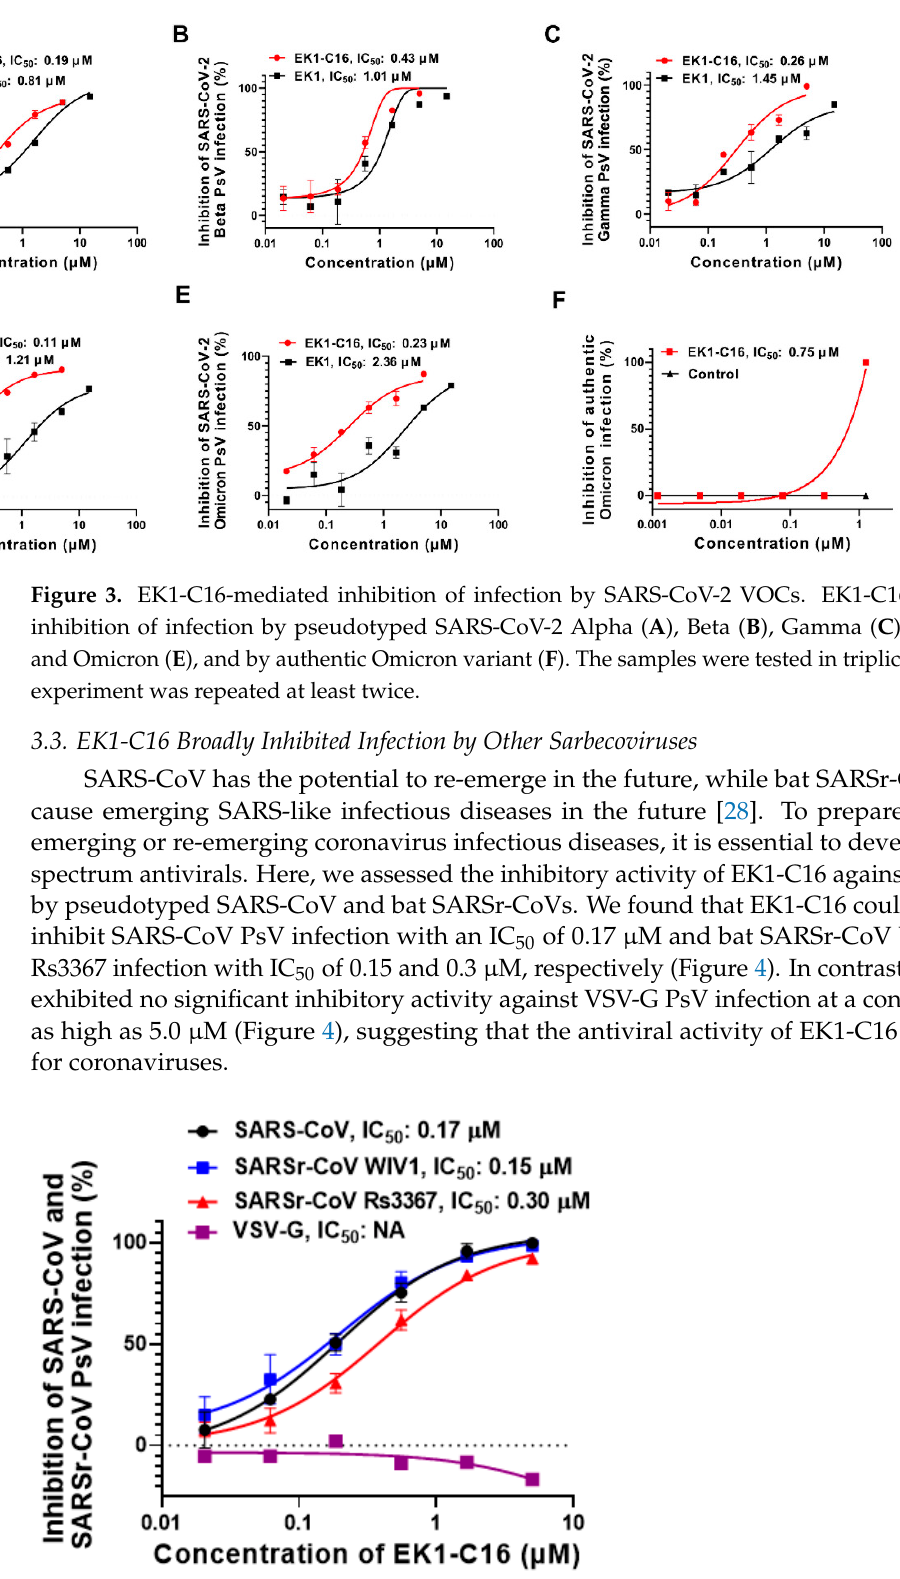
Figure 4. EK1-C16 can broadly inhibit sarbecoviruses. EK1-C16 can inhibit SARS-CoV, WIV1, and Rs3367 PsV, but it has no inhibitory activity against VSV-G PsV-mediated infection, indicating its specificity for sarbecoviruses. Each peptide inhibitor was tested in duplicate, and experiments were repeated